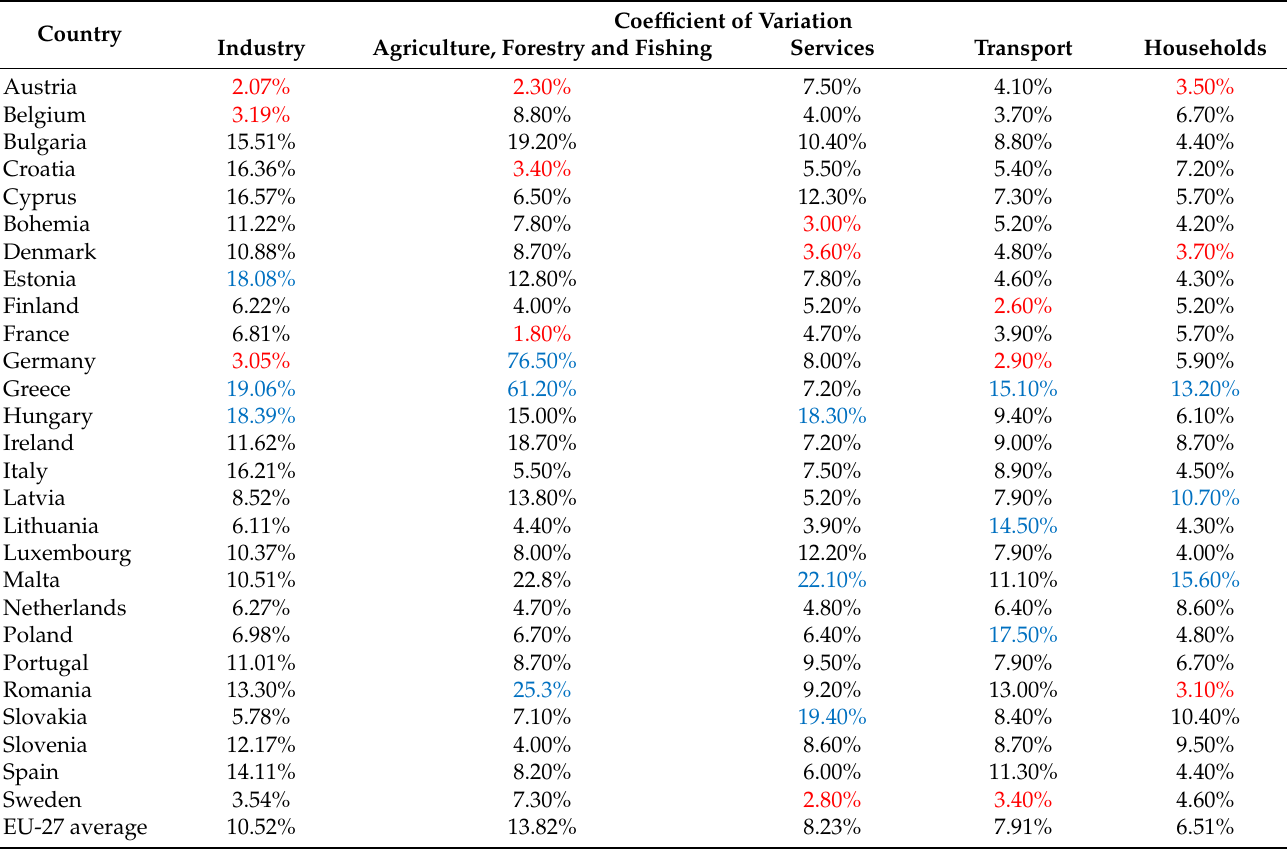
Table 2. Coefficient variation values for final energy consumption by sector and area in EU countries from 2005 to 2020. Blue indicates the three best performers in a given sector, and red the three worst